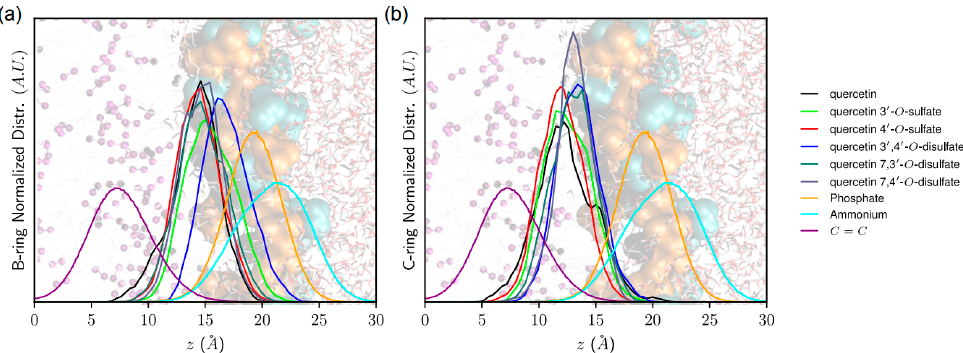
Figure 6. Normalized distribution of ( a ) B-ring and ( b ) C-ring of quercetin derivatives with respect to membrane normal axis (z). Background picture represents water-lipid bilayer interface, highlighting (from left to right) water phase, polar head charged moieties (choline and phosphate moieties depicted in blue and orange, respectively) as well as lipid leaflet region in which POPC C=C double bonds are colored in purple.